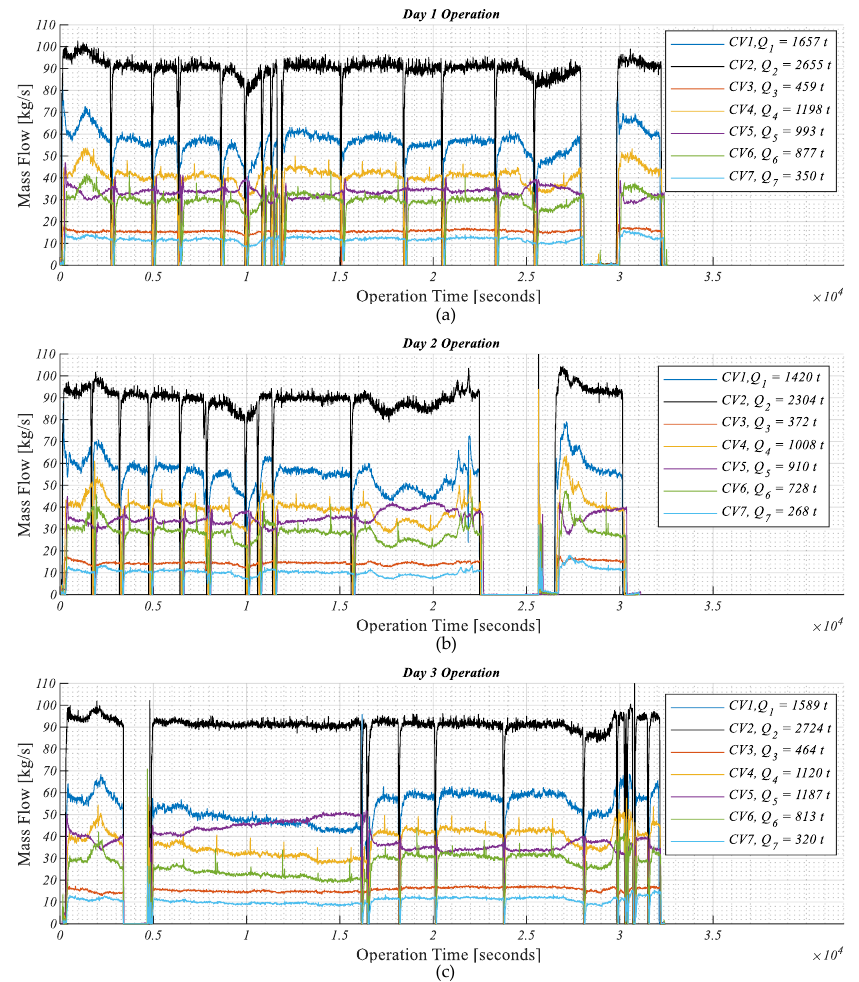
Figure 5. ( a ) Calibration data of mass flow for conveyors using the power-based scale on Day 1, Verification data of mass flow for conveyors using the power-based scale on ( b ) Day 2 and ( c ) Day 3.